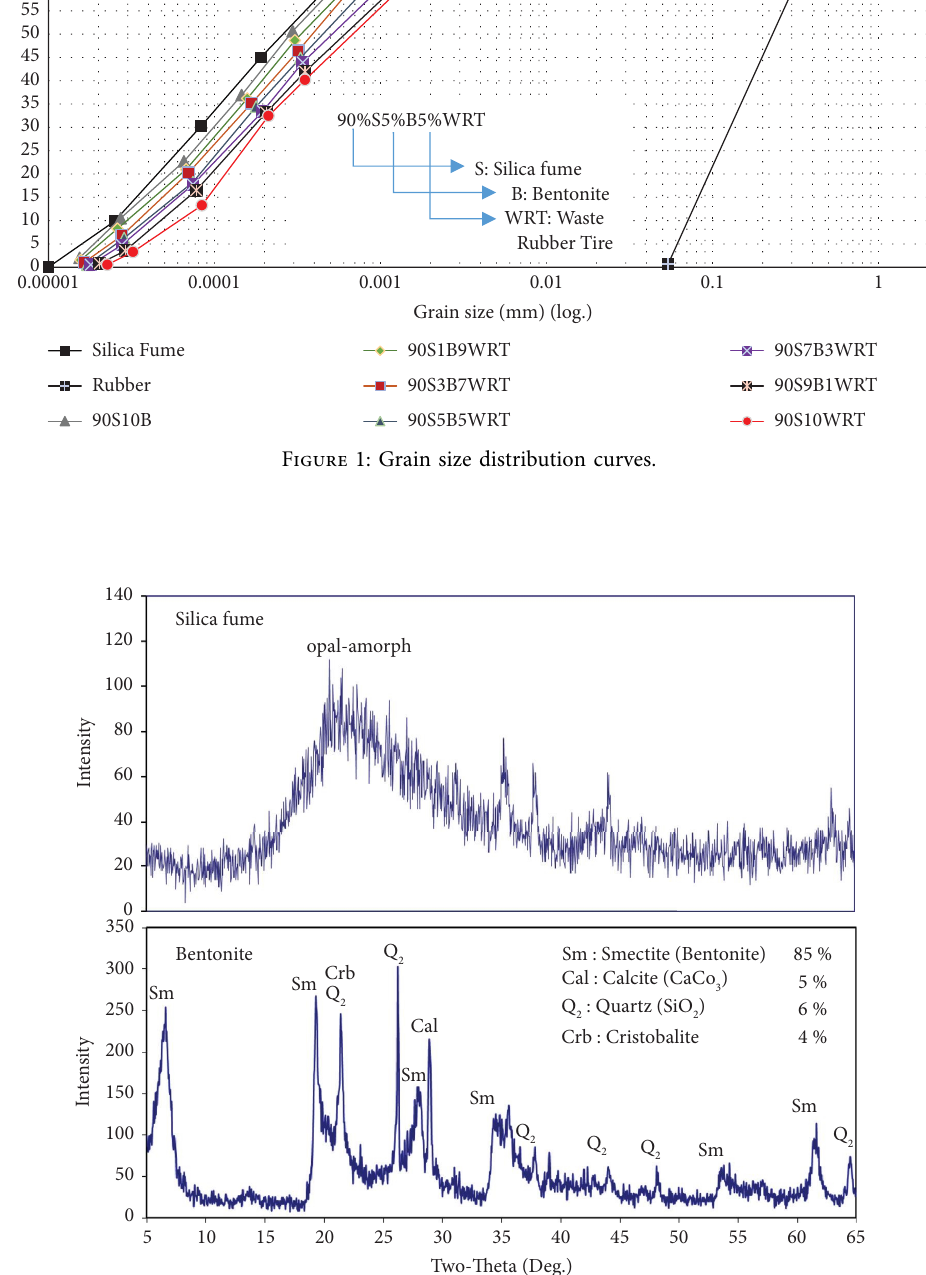
Figure 2: XRD patterns of the bentonite and silica